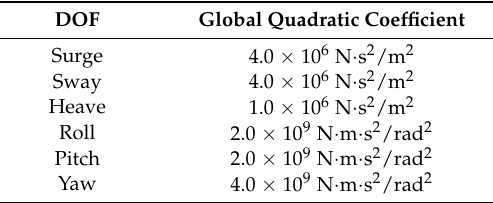
Table 6. Global quadratic damping